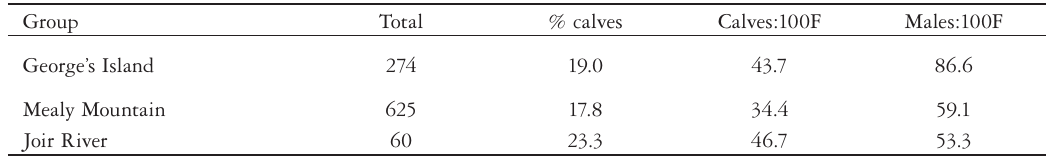
Table 2. Population dynamics for three groups of woodland caribou ( Rangifer tarandus caribou ) in the Mealy Mountain area, Labrador, Canada. March-April,